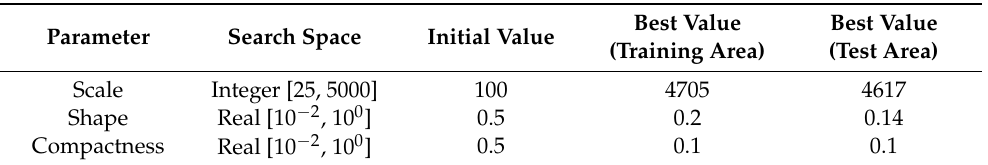
Table 2. Search space, initial values, and best values of MRS segmentation parameters for the training and test areas.